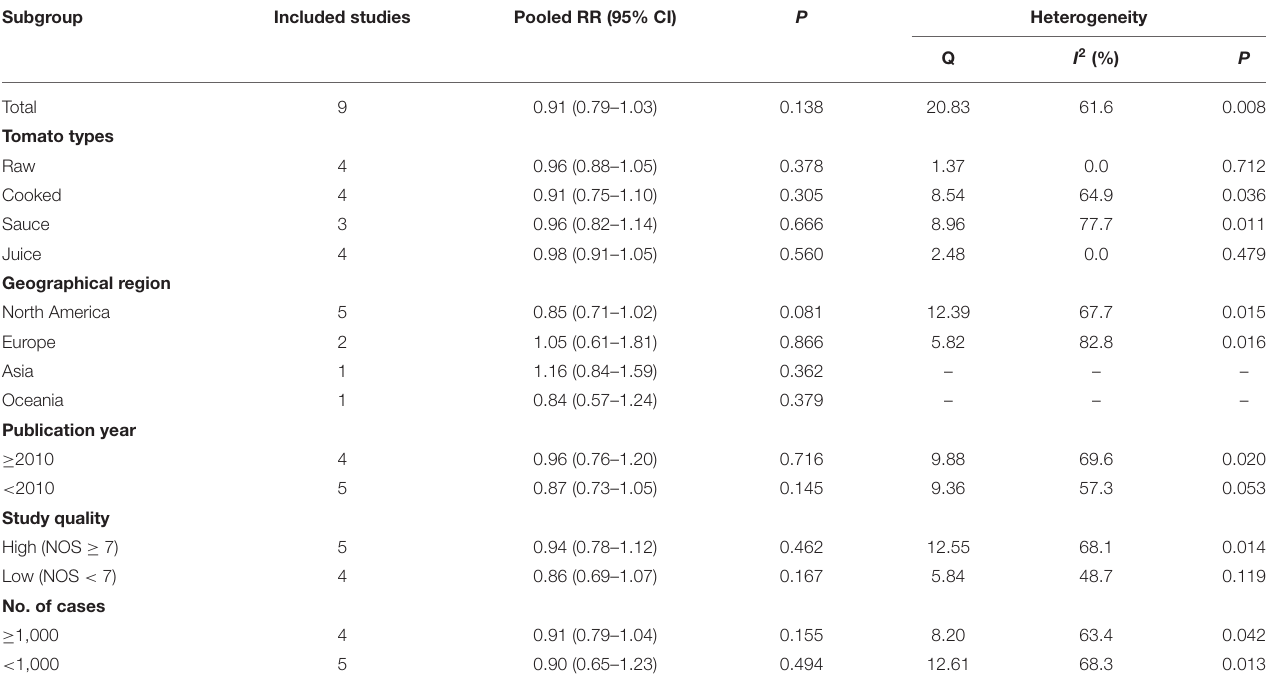
TABLE 2 | Subgroup analysis of tomato intake with prostate cancer